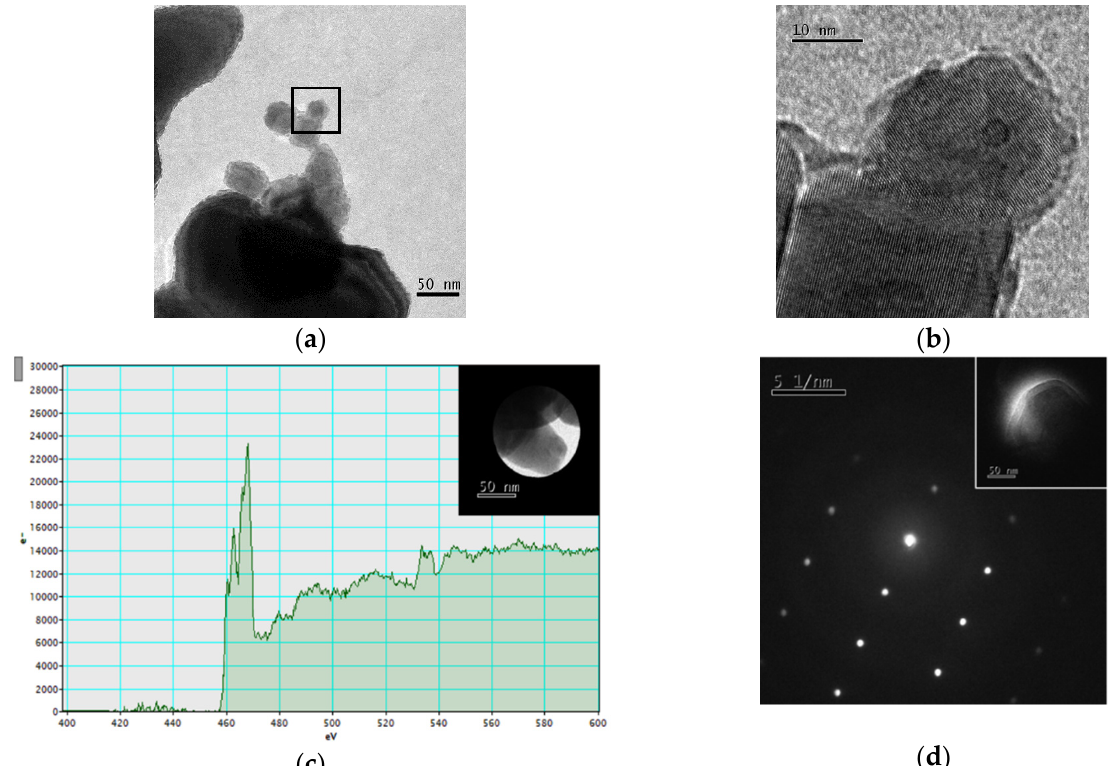
Figure 2. TEM TiO 2 -B NPs characterization. ( a ) TEM micrograph of TiO 2 -B NPs dispersed in water and deposited on a 300-mesh Cu grid coated with carbon film (bar 50 nm); ( b ) HRTEM image which reveals lattice planes of the particles inside the box marked in panel ( a ); ( c ) the EELS spectrum of NPs shown in the inset shows the peaks of the Ti-L 2,3 thresholds (461 eV and 455 eV) and of the O-K threshold (532 eV); ( d ) Electron nanodiffraction pattern of the particle shown in the inset.